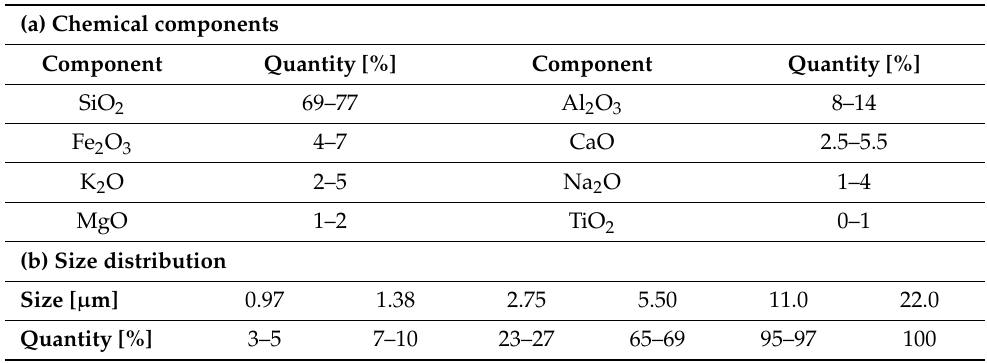
Table 3. Specification of the A1 ultrafine test dust (Powder Technology INC., Arden Hills, MN